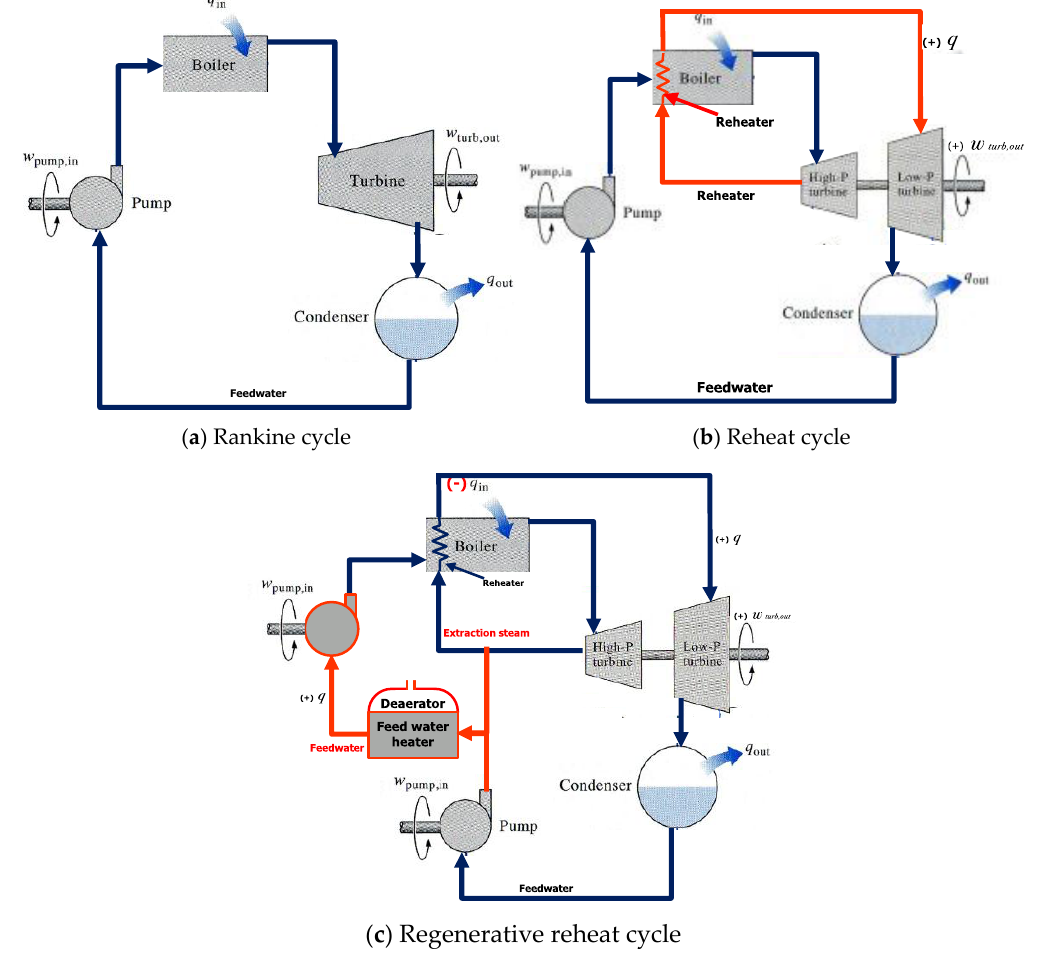
Figure 1. Simple Steam power plant [14].